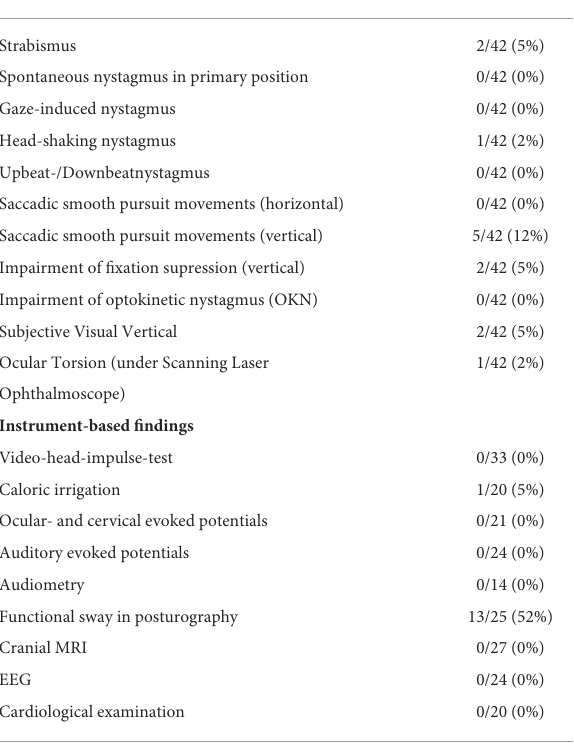
TABLE 2 Detailed ocular motor and instrument-based findings in the attack-free interval in children with RVC. Ocular motor examination %